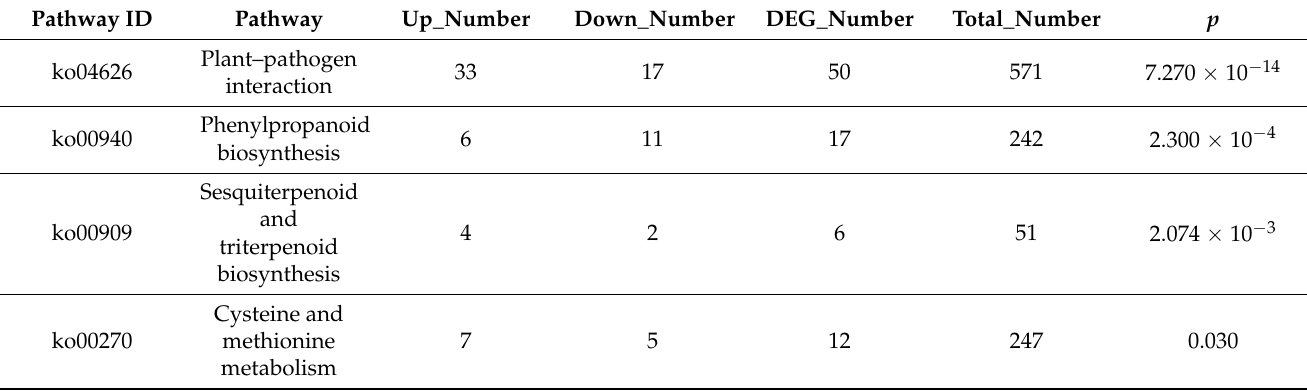
Table 6. KEGG enrichment analysis based on DEGs in the comparison of QLCT vs.